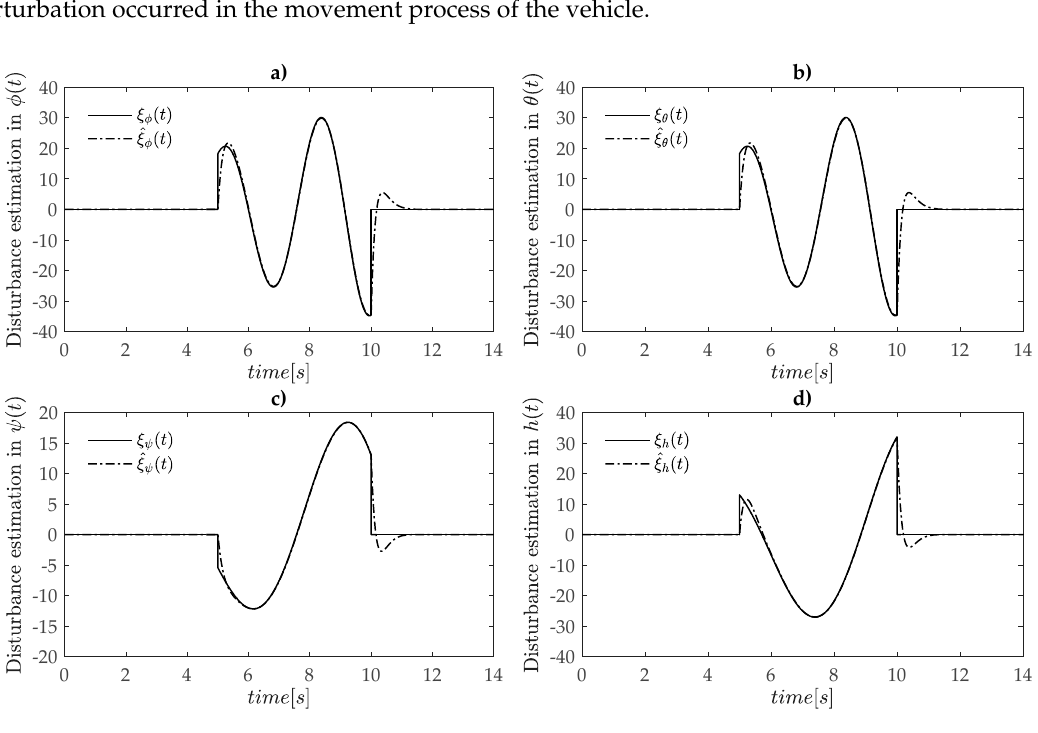
Figure 4. Performance of disturbance observer: ( a ) in roll dynamics; ( b ) in pitch dynamics; ( c ) in yaw dynamics; and ( d ) in altitude dynamics.